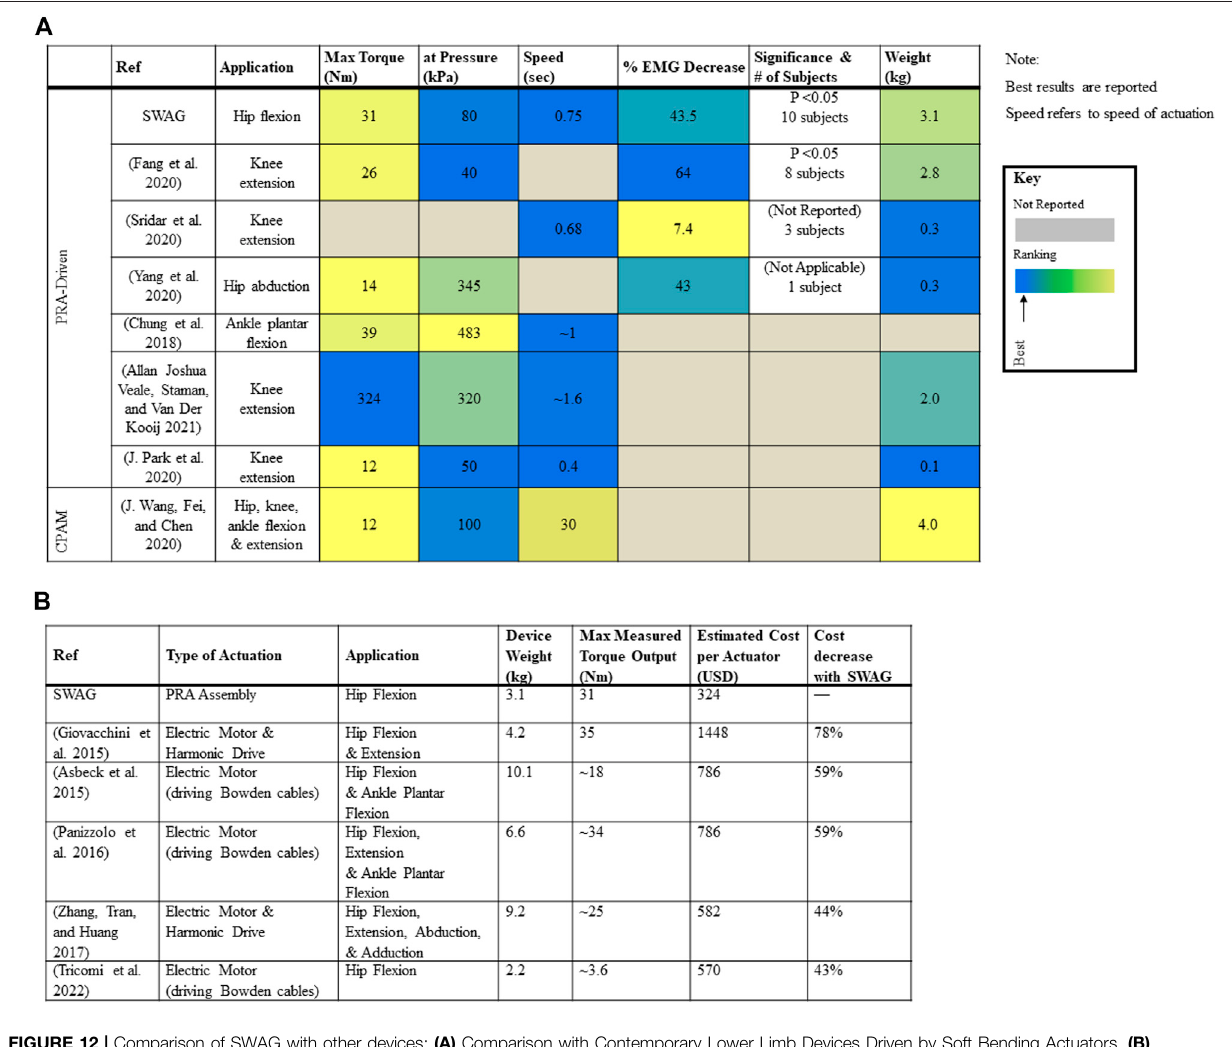
Frontiers in Robotics and AI |